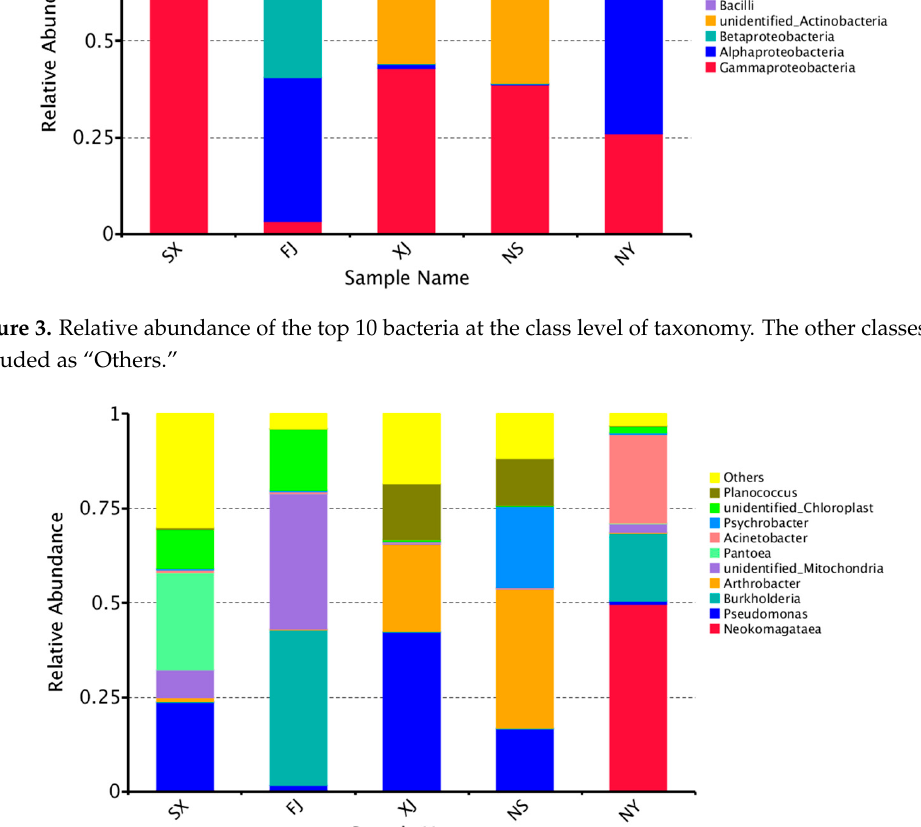
Figure 4. Relative abundance of the top 10 bacteria at the genera level of taxonomy. The other genera are included as “Others.”